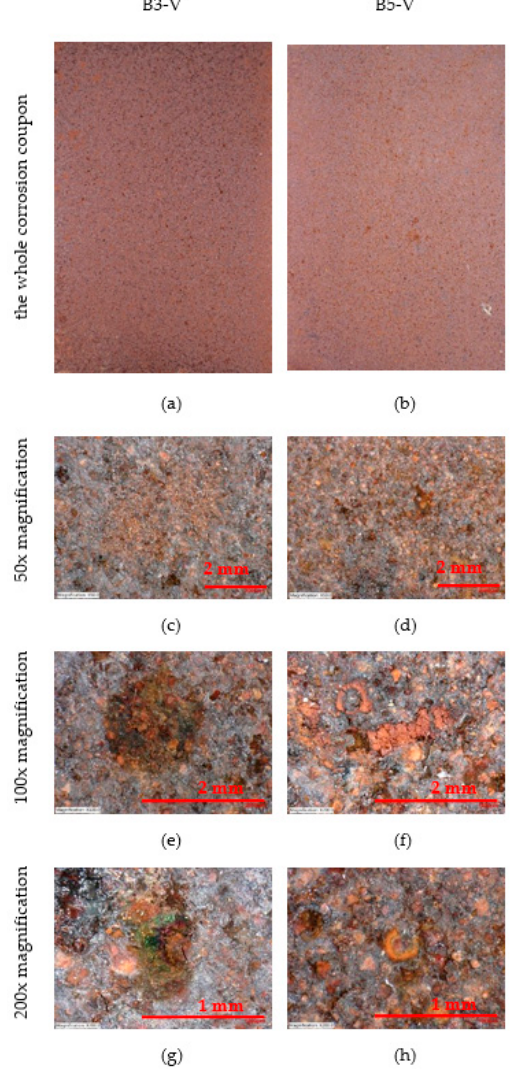
Figure 9. Appearance of vertical corrosion coupons on stands—50×, 100× and 200× magnification. ( a,b ) The whole corrosion coupons; ( c,d ) 50x magnification of corrosion coupon surface; ( e,f ) 100x magnification of corrosion coupon surface; ( g,h ) 200x magnification of corrosion coupon surface.